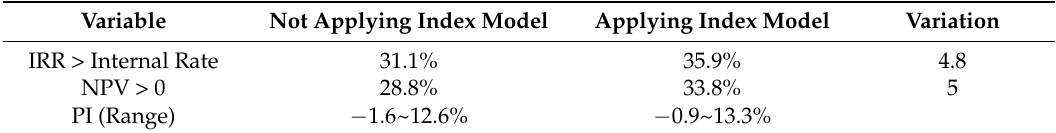
Figure 10. PI Probabilistic Analysis Comparison of Case with and without Model. Table 8. Analysis